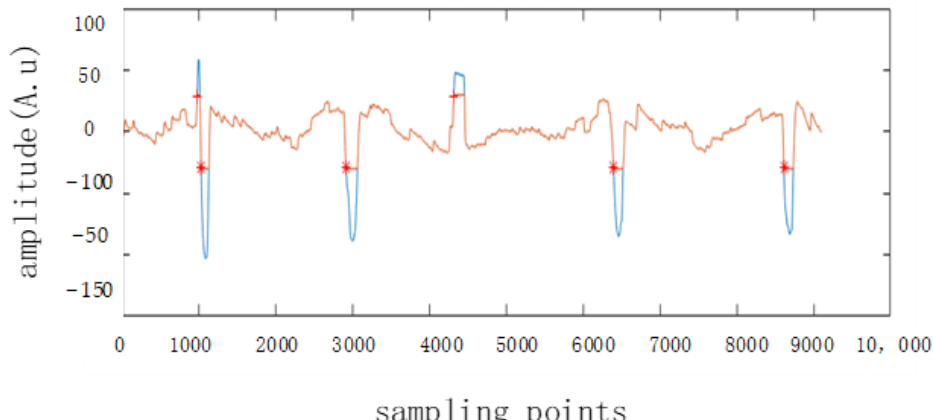
Figure 11. Eye movement signal recognition (red+ indicates right movement, red* indicates left movement).